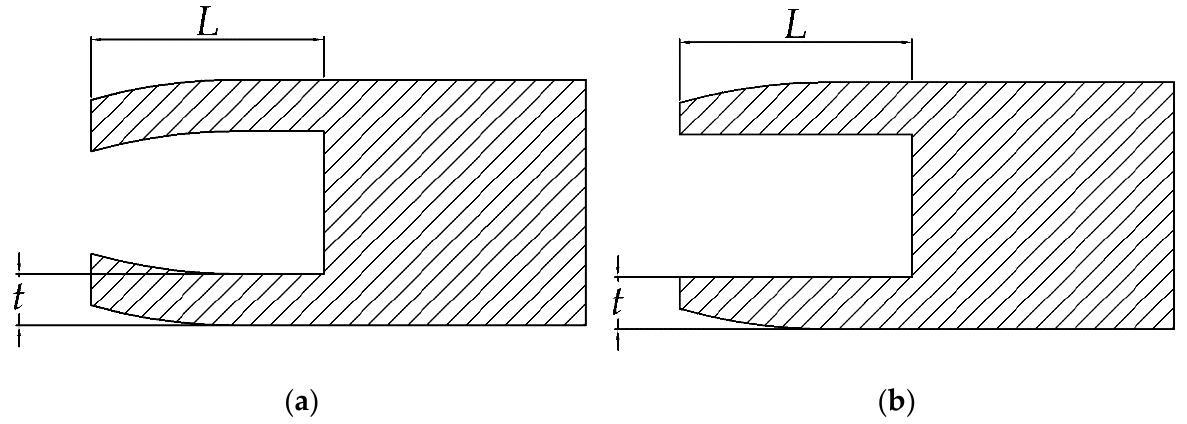
Figure 7. The shape of the hollow mandrel section in ( a ) hollow mandrel scheme 1 and ( b ) hollow mandrel scheme 2.